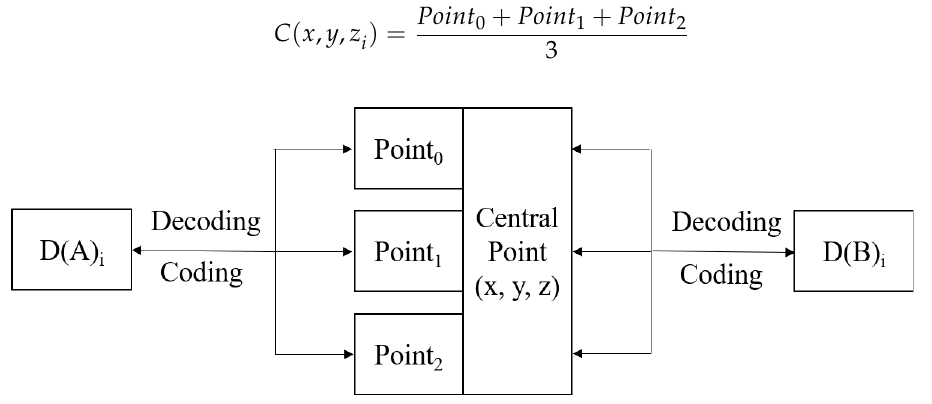
Figure 11. Flow chart of resampling conversion method.